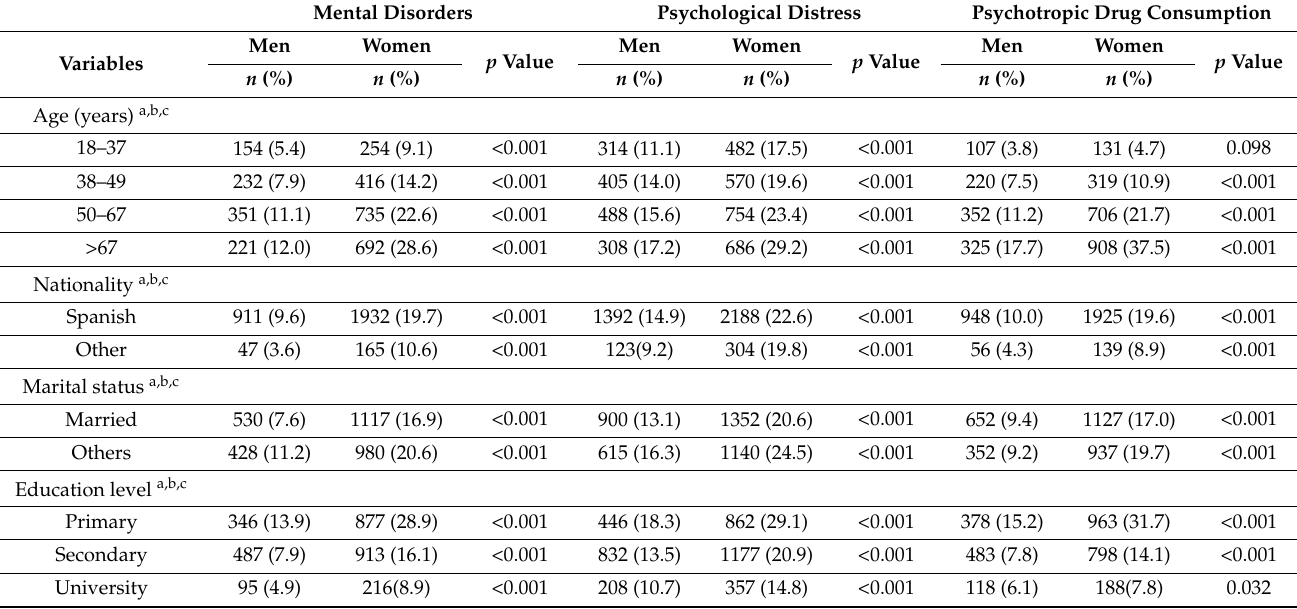
Table 1. Prevalence of mental disorders, psychologic distress and psychiatric drug consumption among men and women according to sociodemographic variables. Results from the Spanish National Health Interview Survey 2017.